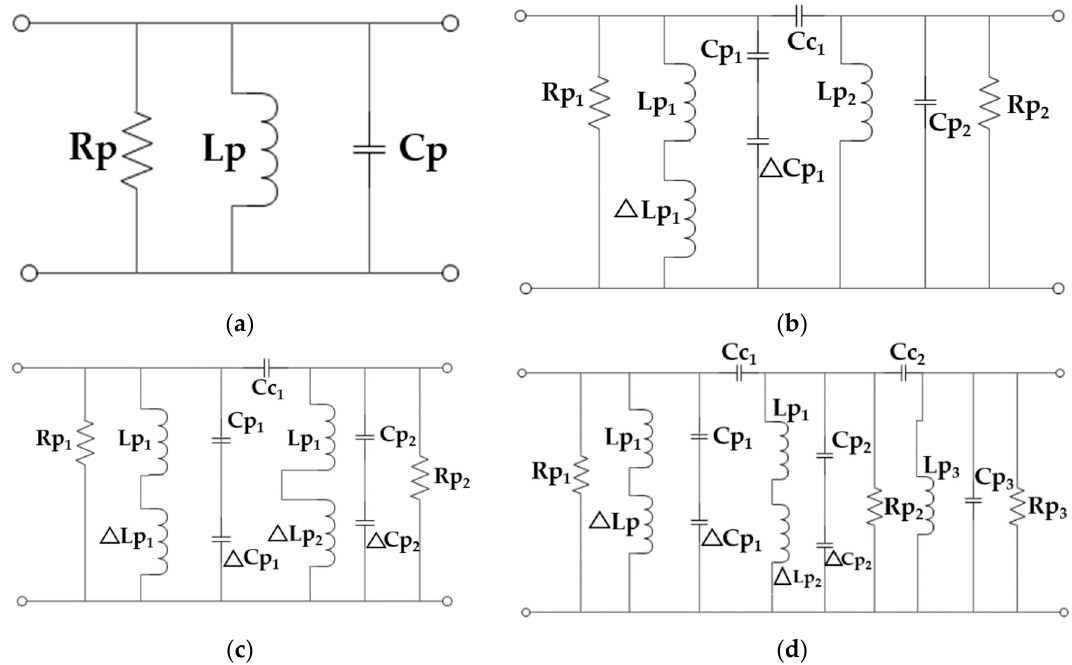
Figure 11. The equivalent circuit of various configurations of the antenna. ( a ) Simple patch antenna; ( b ) Patch antenna with inset; ( c ) Patch antenna with inset and single stub; ( d ) Patch antenna with inset and all stubs.